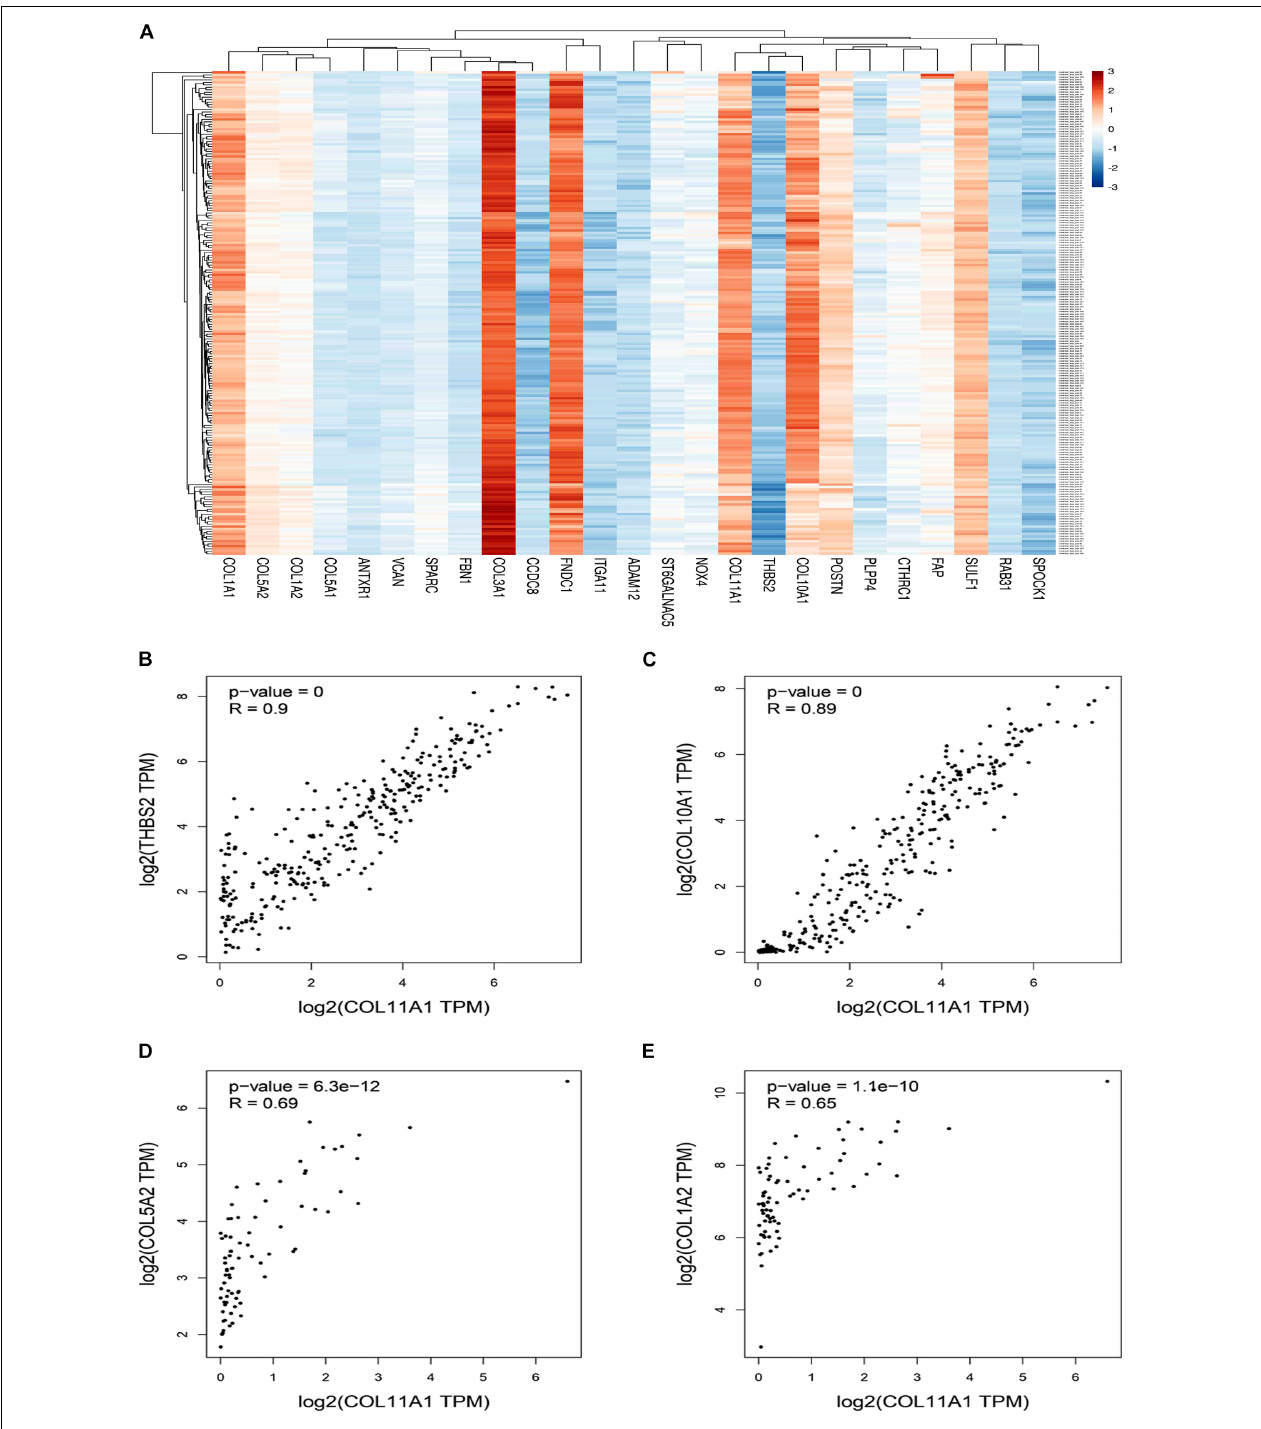
FIGURE 4 | Coexpression and correlation of genes functionally associated with COL11A1. (A) Clustered heatmap of the top 25 correlated genes (Scaling in –3/3 with mean-centered to 0). (B–E) Graphical representation of Pearson’s correlation test of COL11A1 gene with, (B) THBS2, (C) COL10A1, (D) COL5A2, (E) COL1A2.